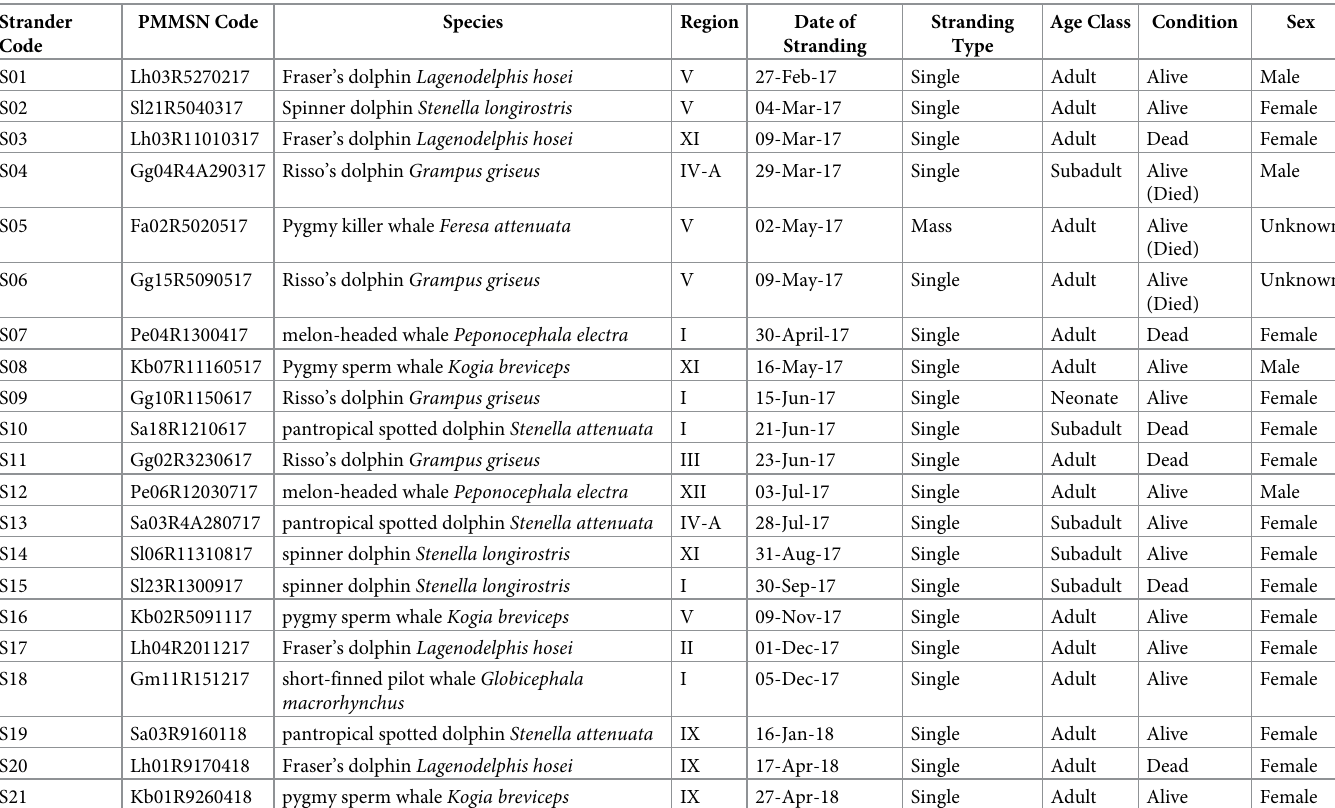
Table 2. Stranded cetaceans sampled for the study (2017–2018). Strander